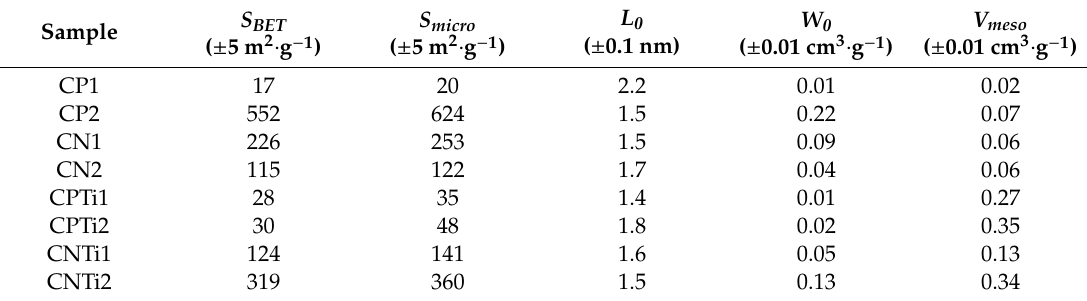
Table 2. Textural characteristics of the carbon–Ti composites.